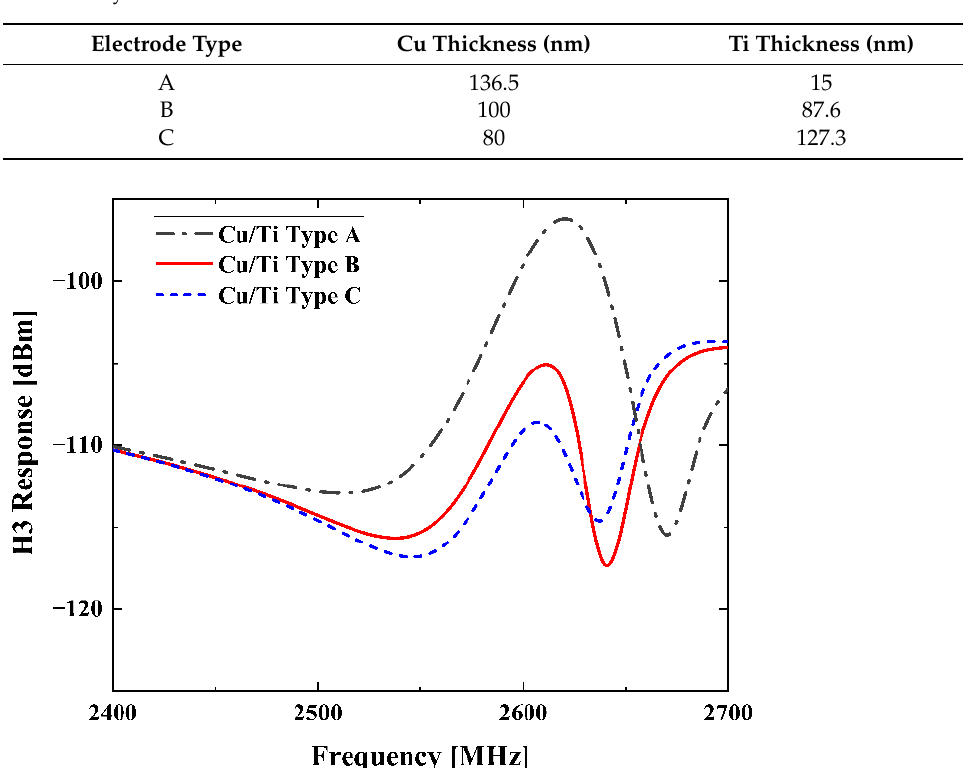
Table 1. Layer Thicknesses of Different Electrodes.